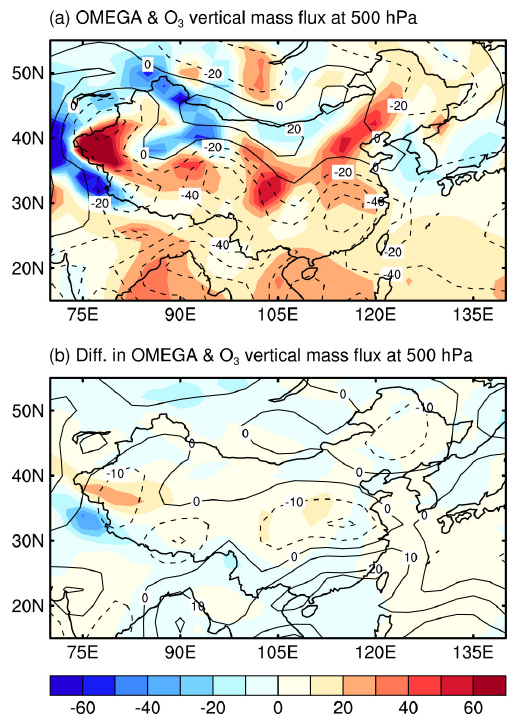
Figure 8. (a) The spatial distributions of JJA mean vertical wind velocity (contours, Pas − 1 · 1000) and simulated upward mass flux of O 3 (shades, kgs − 1 ) averaged over years 1986–2006. (b) The composite differences in vertical wind (contours, Pas − 1 · 1000) and simulated upward mass flux of O 3 (shades, kgs − 1 ) between the five weakest and strongest EASM years (weakest–strongest). Vertical winds are from the NCEP/NACR reanalysis